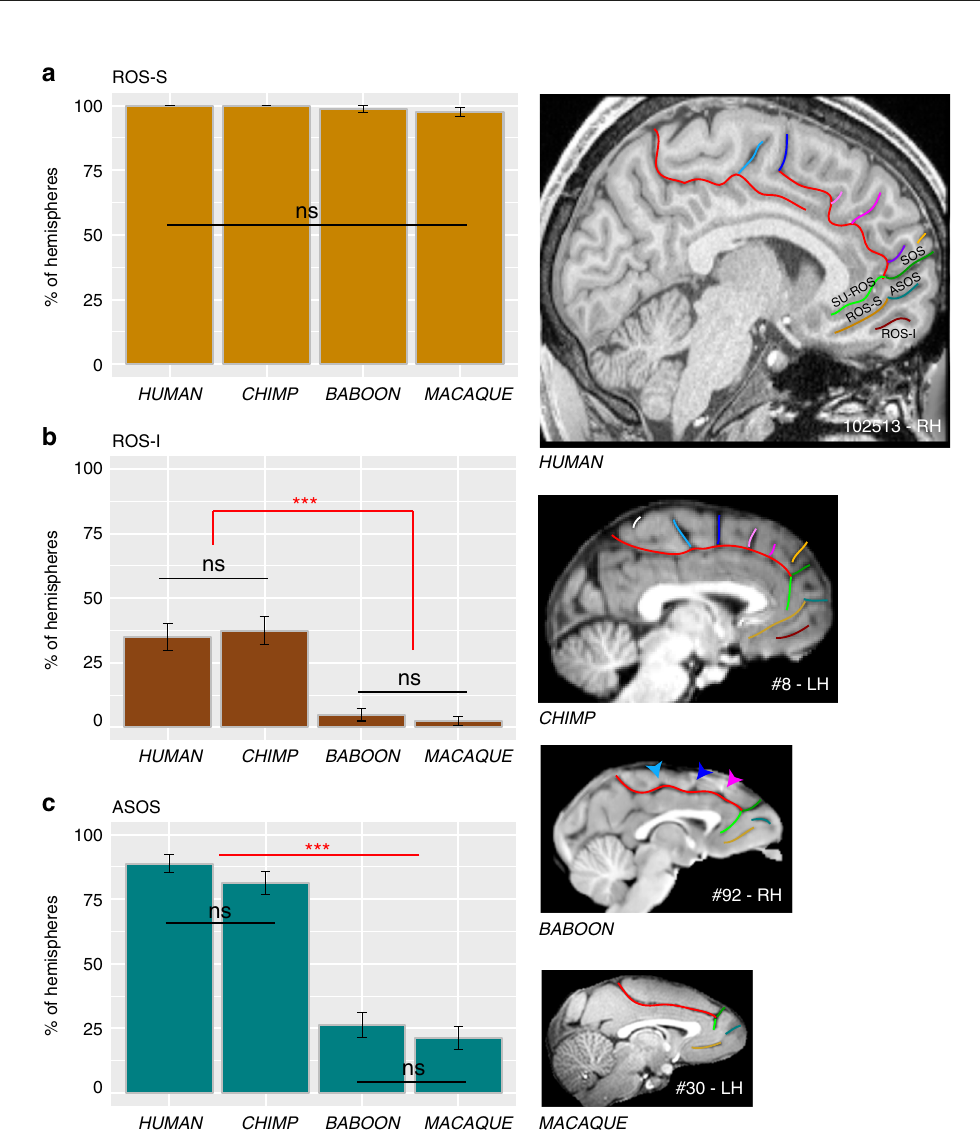
Fig. 6 Sulci present in the ventral MFC across primates. The location of the ROS-S, ROS-I, and ASOS sulci are displayed in human, chimpanzee, baboon, and macaque brains in the right panels. a The probability of occurrence (±s.e.m.) of ROS-S is similar in human and non-human primates. b The probability of occurrence (±s.e.m.) of ROS-I is comparable in human and chimpanzee and is almost absent in Old-world monkeys. c The probability of occurrence of ASOS is equal in human and chimpanzee. It is decreased in Old-world monkeys but equally present in baboon and macaque. Statistics: * p < 0.05, ** p < 0.01, *** p < 0.001, ns non-signi fi cant. Source data are provided as a Source Data fi